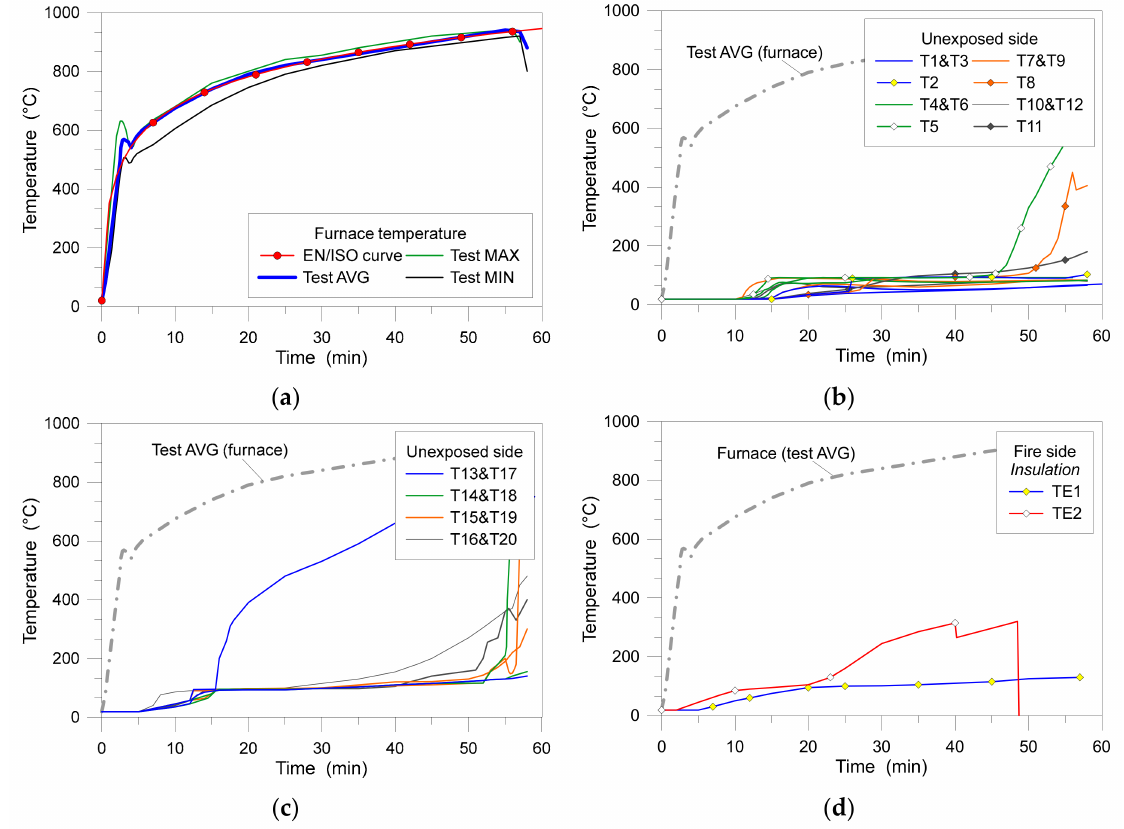
Figure 4. Experimental distribution of temperatures, as recorded during the fire test ( a ) within the furnace and ( b , c ) on the unexposed side of the W80 specimen (( b ) = main logs, ( c ) = outriggers), with ( d ) temperature evolution within the gypsum fibreboard insulation